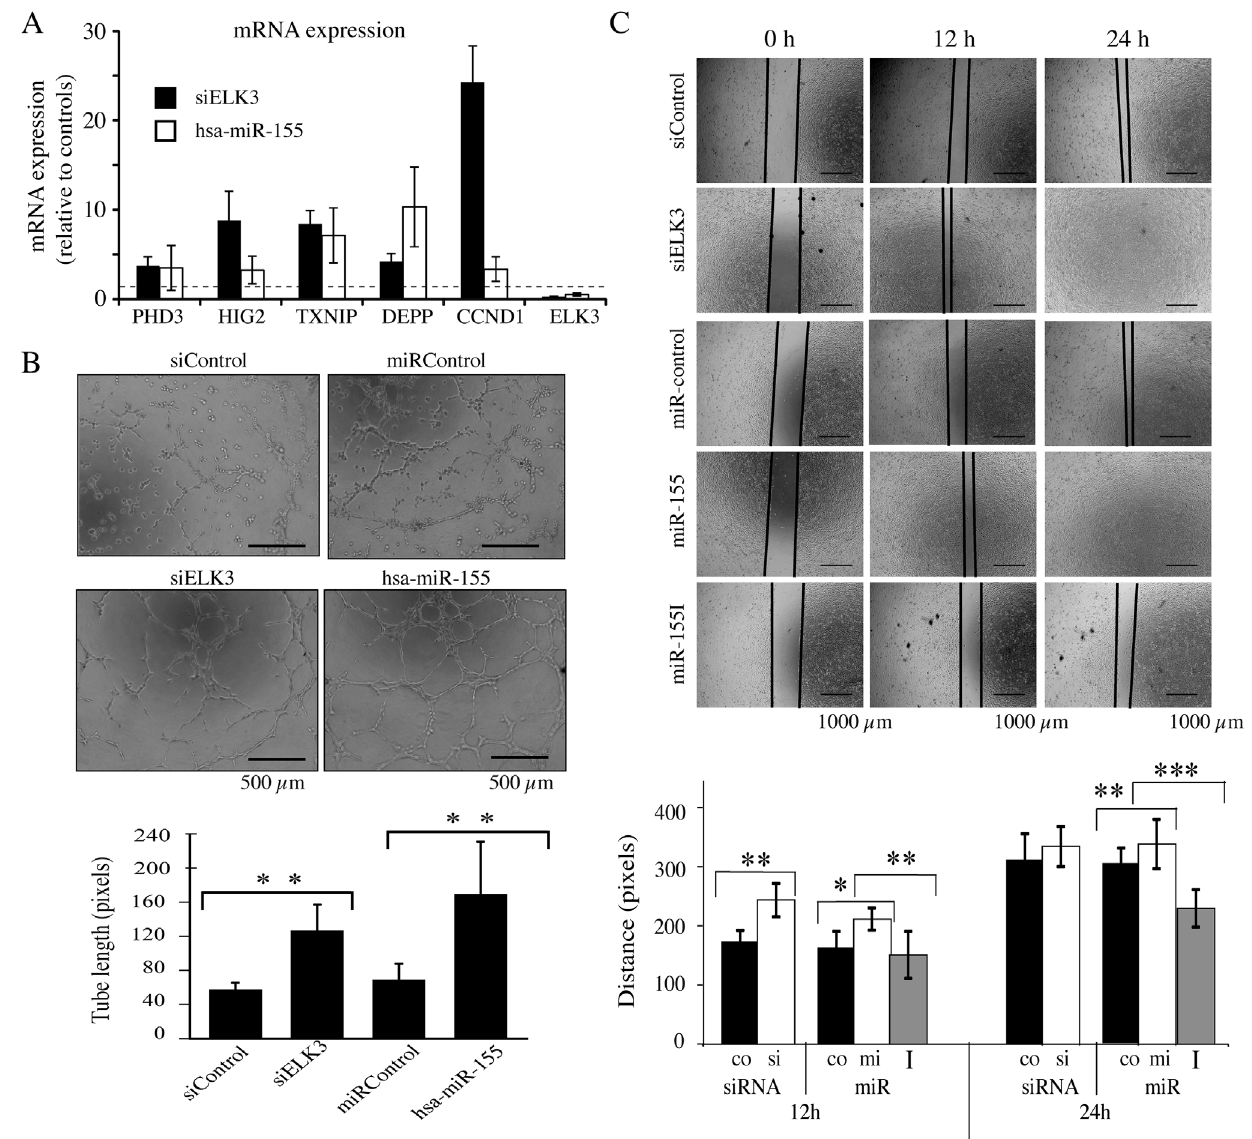
Figure 5. Similar effects of miR-155 mimic expression and ELK3 RNA down-regulation on gene expression, tube formation and migration. (A) mRNA levels of ELK3 target genes, measured by RT-QPCR, 24 h after treatment with either siELK3 or miR-155 mimic, normalised to the corresponding controls (Four separate transfections were analysed for miR-155 and two for siELK3, error bars represent the S.D. between experiments.). (B) Tube formation of HUVEC cells after expression of miR-155 mimics or siELK3 in comparison to the controls (representative pictures, the experiment was repeated 5 times, **p , 0.001). The bars represent 500 m m. (C) Cell migration post-transfection with miR-155, siELK3, miR-155 inhibitor or the controls at times 0 h, 12 h and 24 h from the scratch. (Measurements are means of 3 fields per wound. Statistical significance was determined by student t- test, the experiment was repeated 3 times, *p , 0.01, **p , 0.001, ***p , 0.0001 error bars represent S.D). The bars represent 1000 m